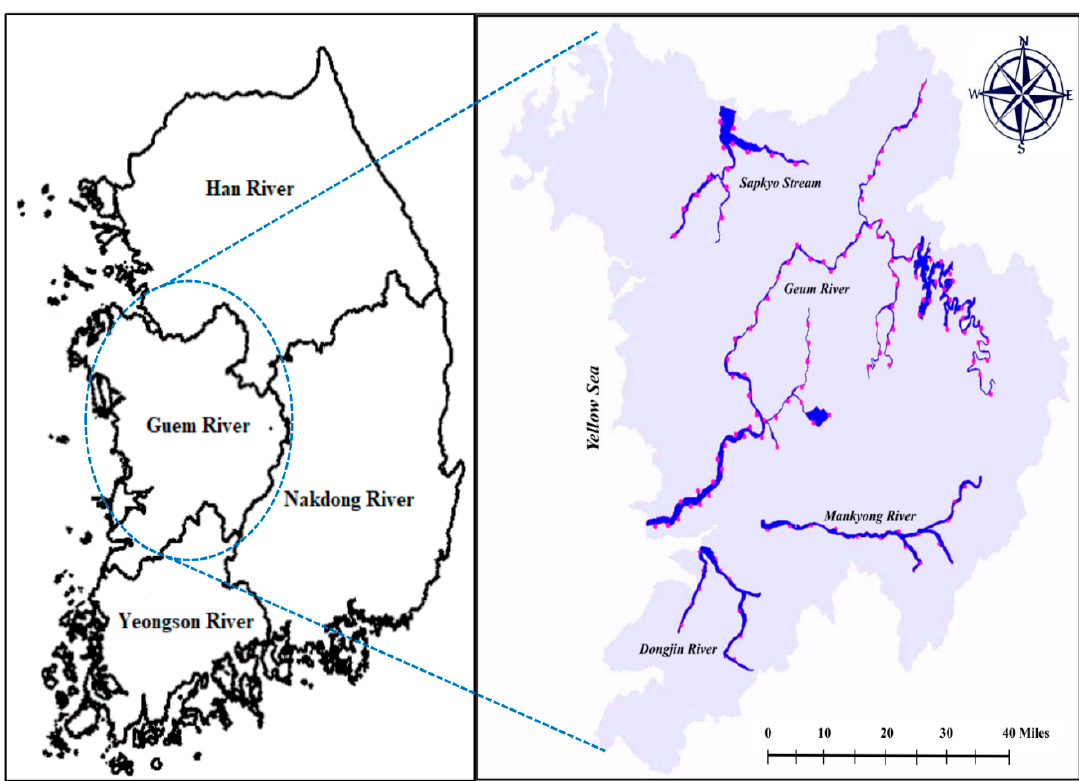
Figure 1. Arrangement of study sites in Geum River watershed and the sub-watersheds.